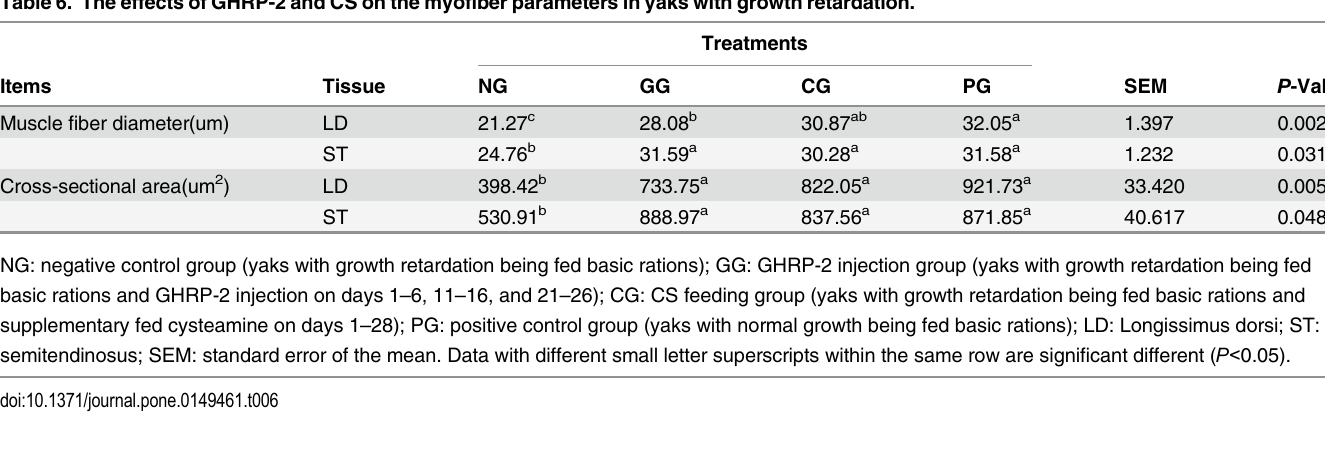
bottom of the somatotropic axis and plays an influential role in cell growth and differentiation